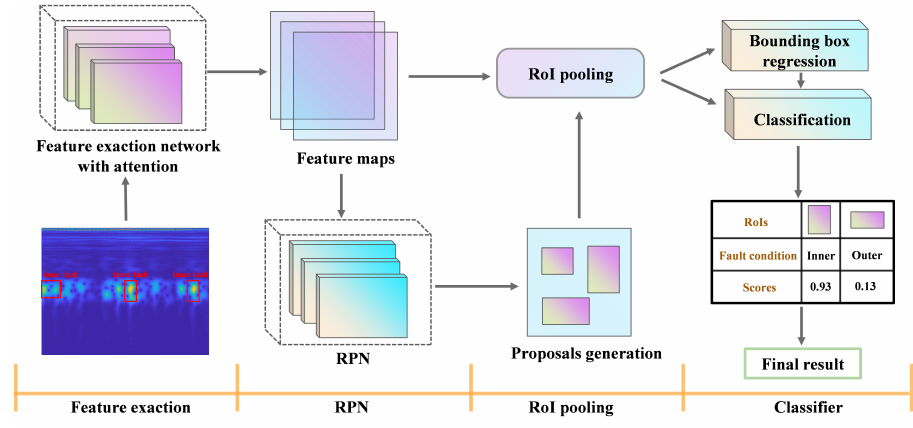
Figure 6. The network architecture of